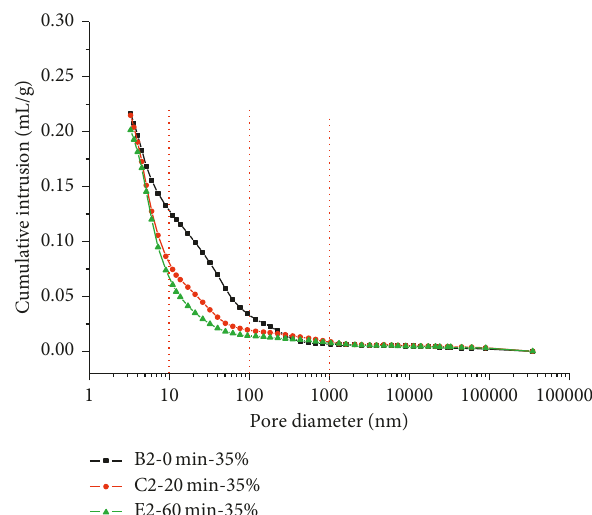
Figure 6: Cumulative pore volumes of specimens with 35% of slag cured for 28